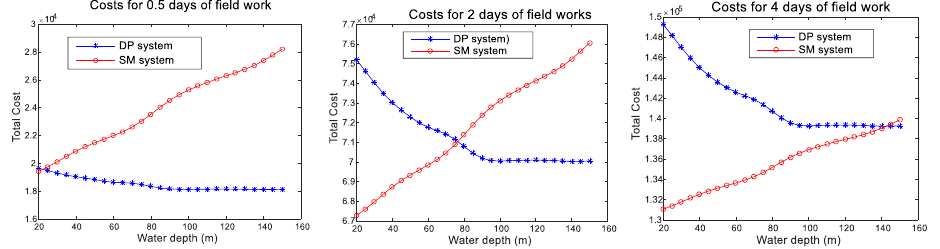
Figure 11. Cost comparison for different days of fieldwork in ERN 0 condition.